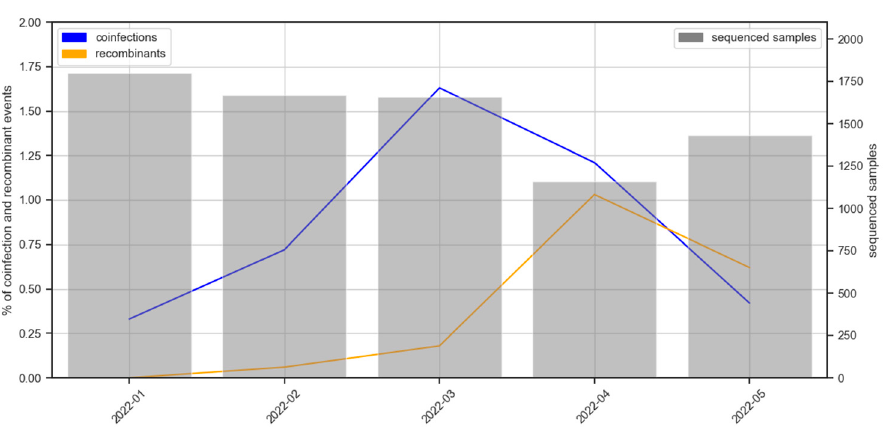
Figure 3. Percentage of co-infection events and recombinants observed in the samples sequenced along the period January-May 2022 (scale in the left Y axis). Bars indicate the total number of sam- ples sequences per month (scale in the right Y axis).